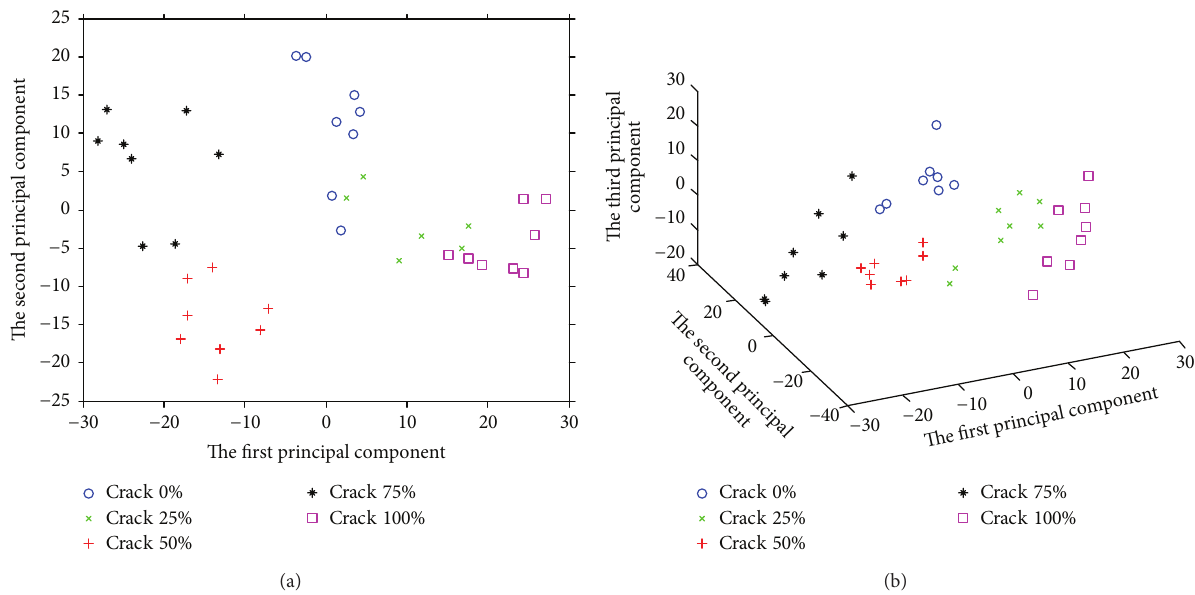
Figure 10: The principal components of the training data for experiment 3 : (a) the first two principal components; (b) the first three principal components.